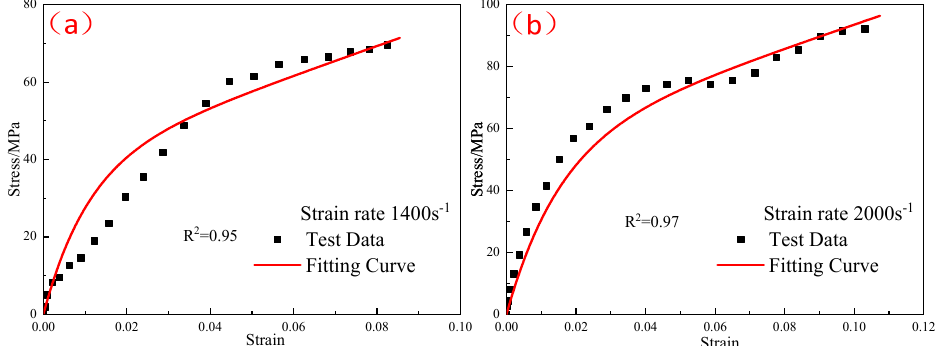
Figure 19. Comparison of the fitting results of the ZWT constitutive model with the experimental results under different strain rates at − 20 °C: ( a ) 1400 s − 1 ; ( b ) 2000 s − 1 .